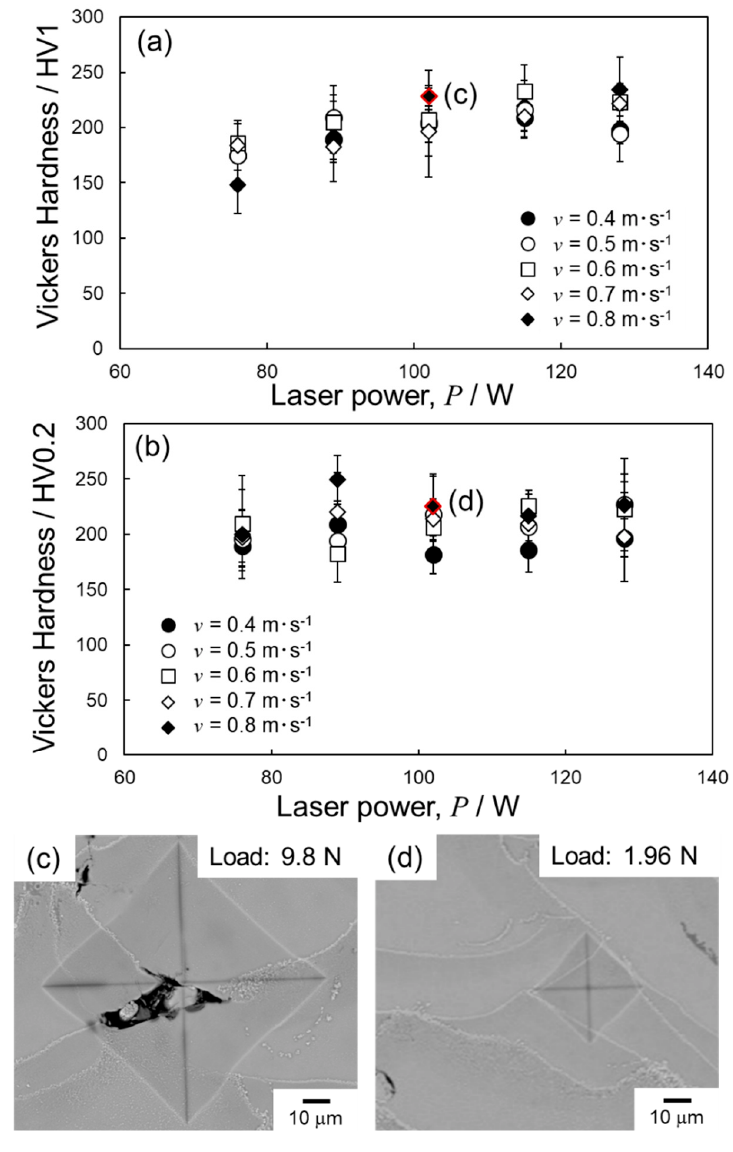
Figure 7. ( a , b ) Change in Vickers hardness (HV1 and HV0.2) of the samples measured at two different loads of ( a ) 9.8 N and ( b ) 1.96 N. ( c , d ) Representative SEM images showing indents on the sample surface under ( c ) 9.8 N and ( d ) 1.96 N.